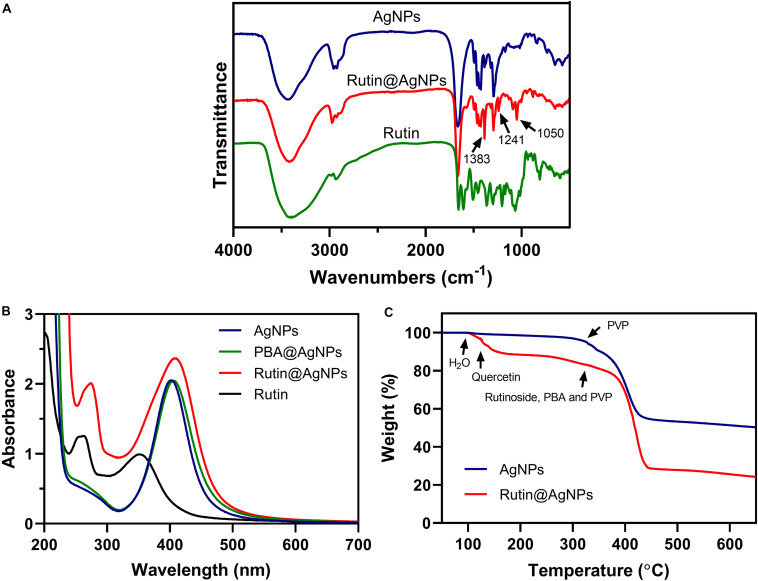
(A) FTIR spectra of AgNPs, Rutin@AgNPs, and rutin; (B) UV-vis spectra of AgNPs, PBA@AgNPs, Rutin@AgNPs, and rutin; (C) TGA curves of AgNPs and Rutin@AgNPs.